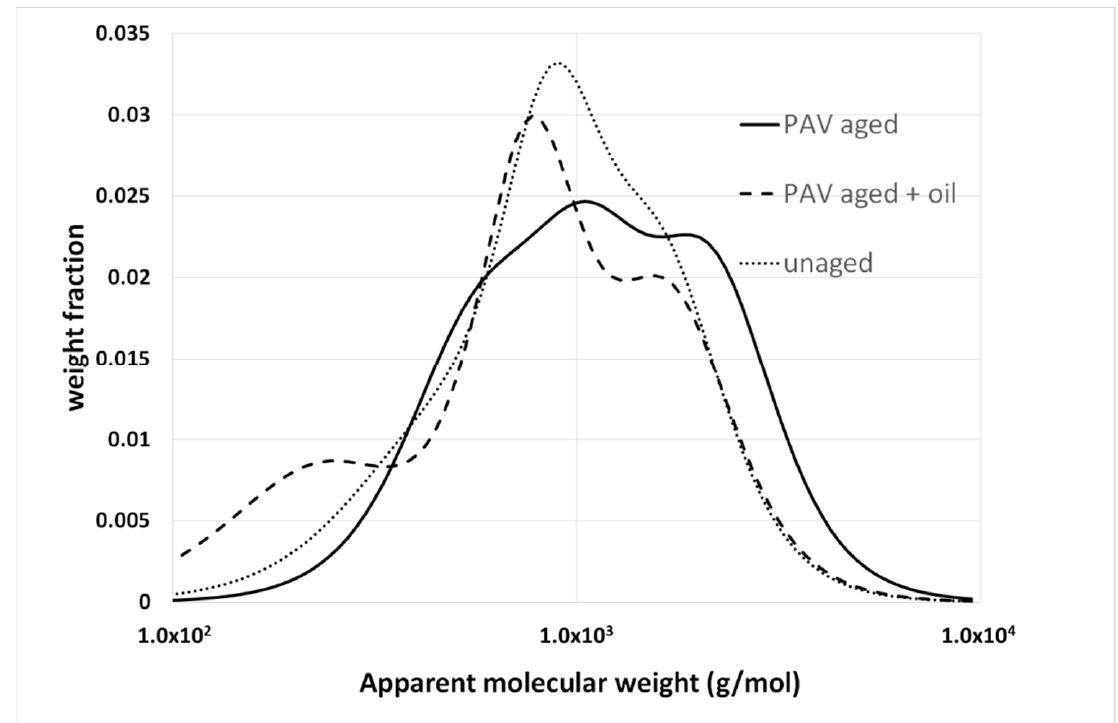
Figure 9. BMWDs of original PAV-aged and rejuvenated 50/70 binder.